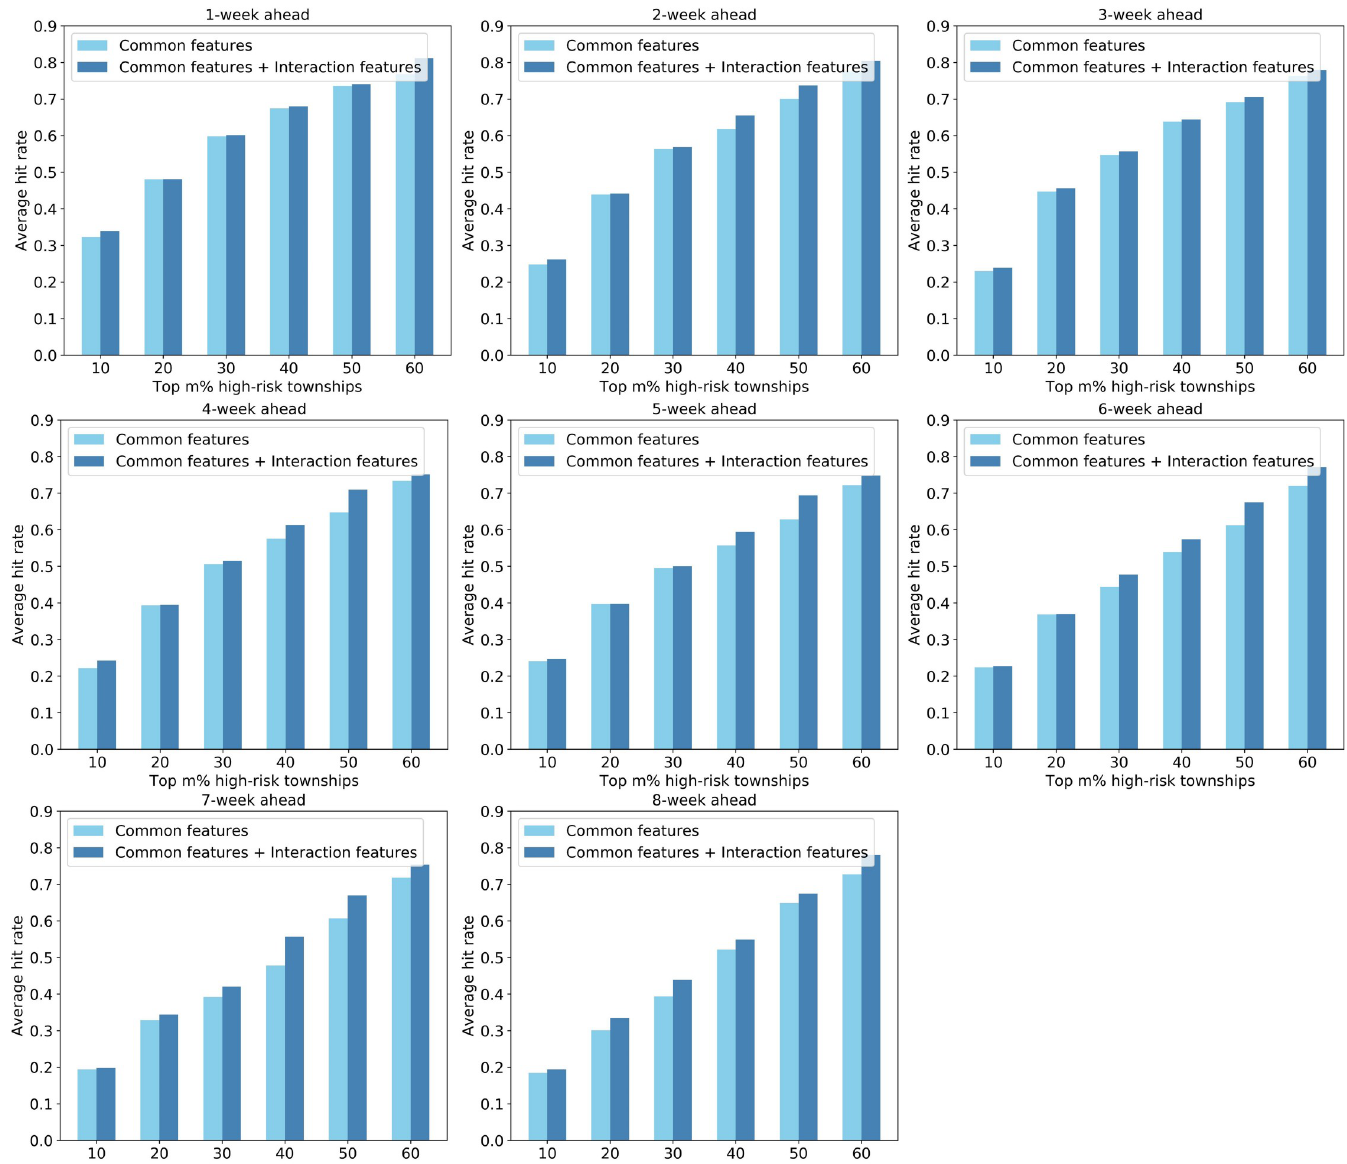
Fig 11. Performance comparison of the SVM-based models with and without interaction features based on the hit rate metric.